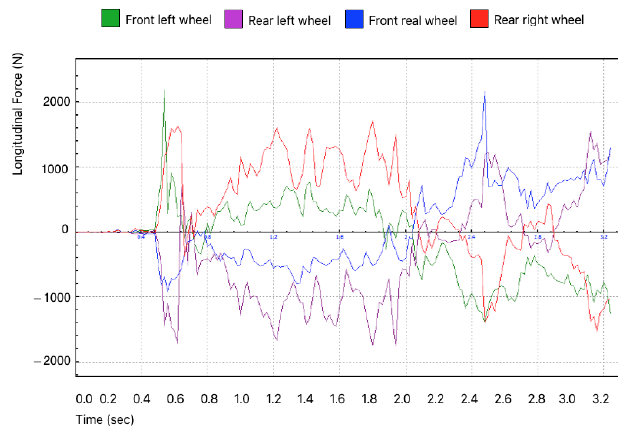
Figure 16. Longitudinal force in conventional deflection (L = 3500